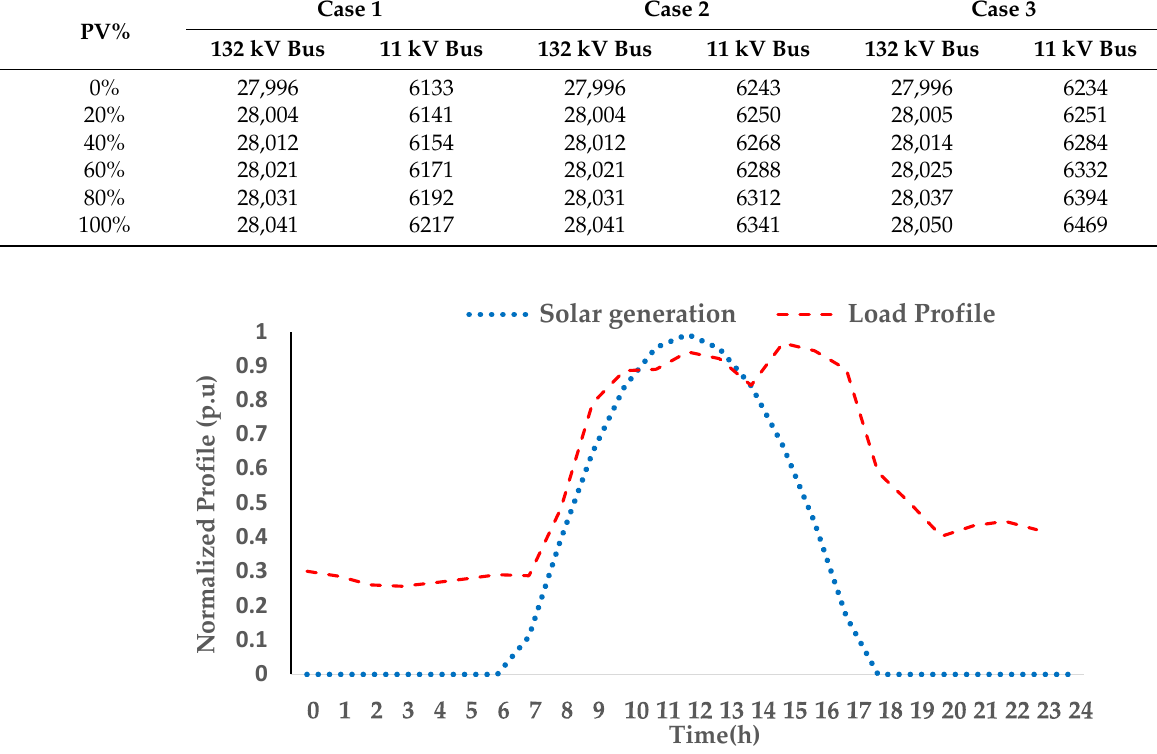
Figure 6. Normalized load consumption and solar PV generation pro fi le.